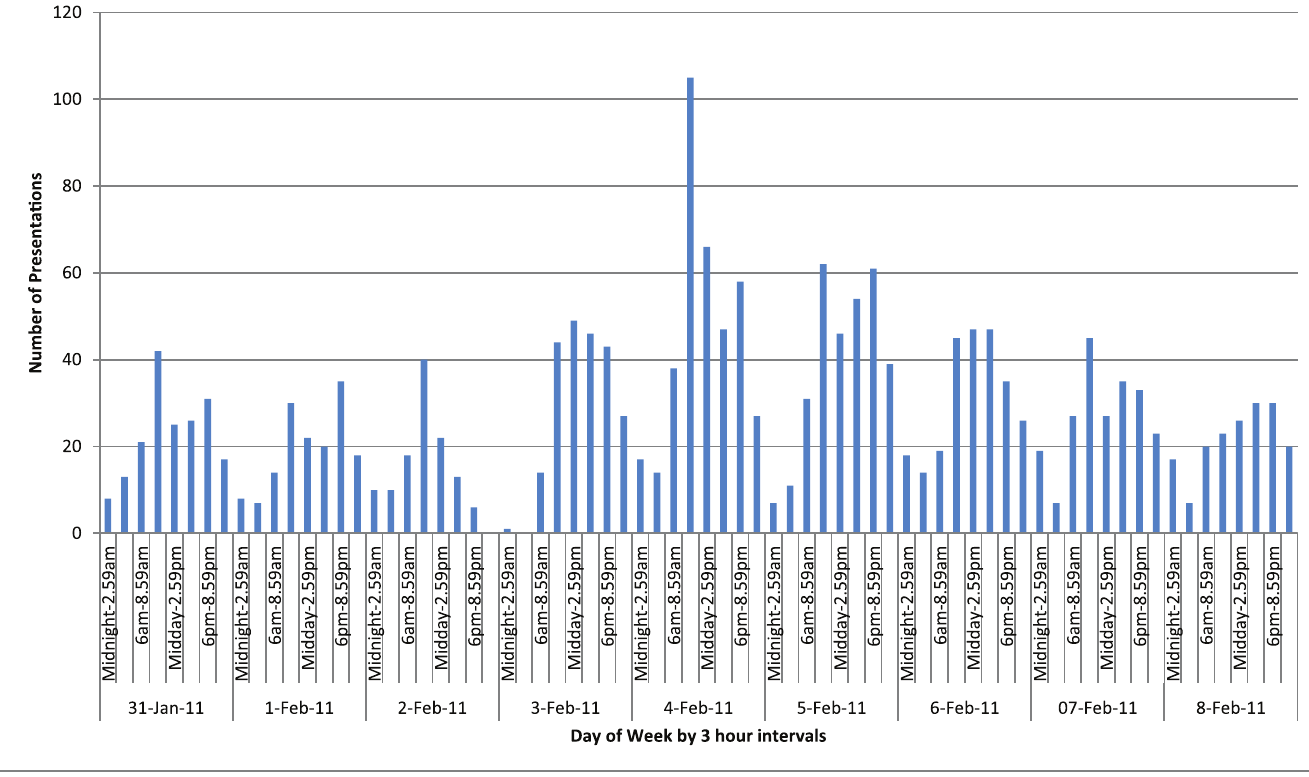
Fig 3. Townsville Emergency Department presentations by 3 hour periods and day, 31-Jan-2011 to 8-Feb-2011.